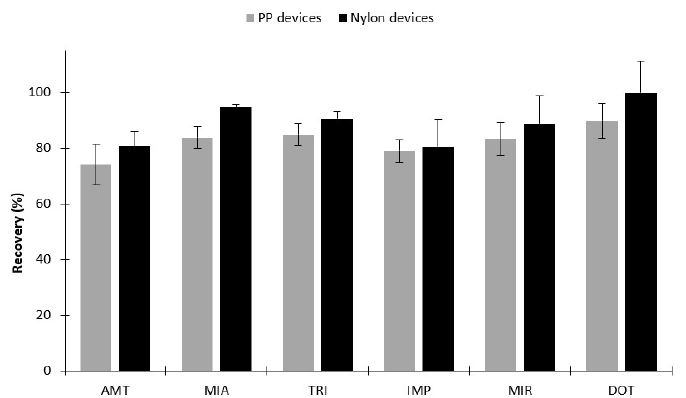
Figure 5. Effect of substrate type on the microextraction efficiency for the six TCAs in aqueous media by BAμE(C18)-μLD/LVI-GC-MS(SIM). The error bars represent the standard deviation of three replicates.